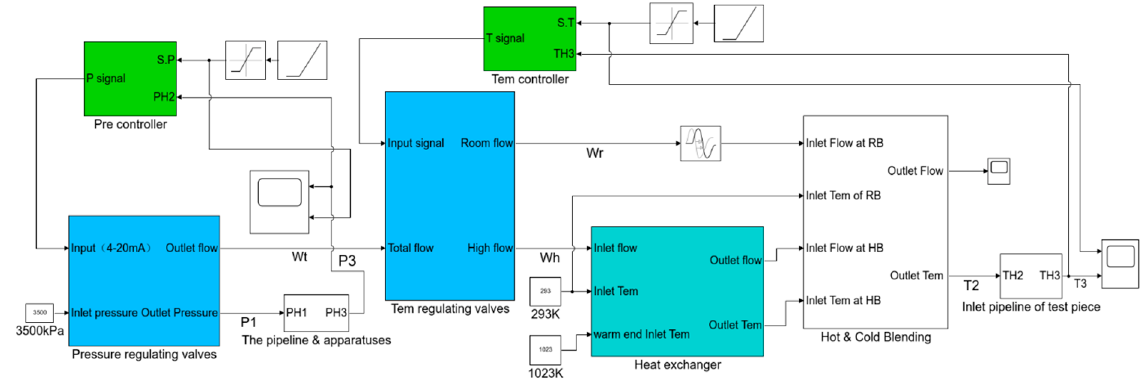
Figure 4. Simulation model diagram of the system.